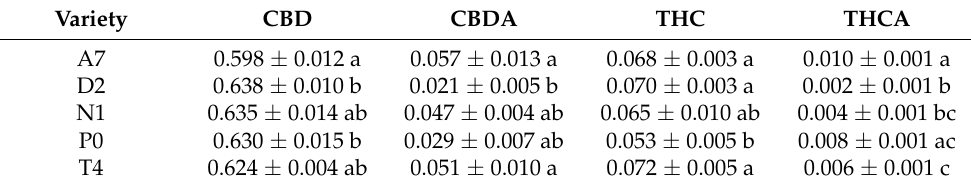
Table 1. Content in CBD. CBDA. THC and THCA in the plant extracts expressed as µ g/ µ g extract (mean ± SE).